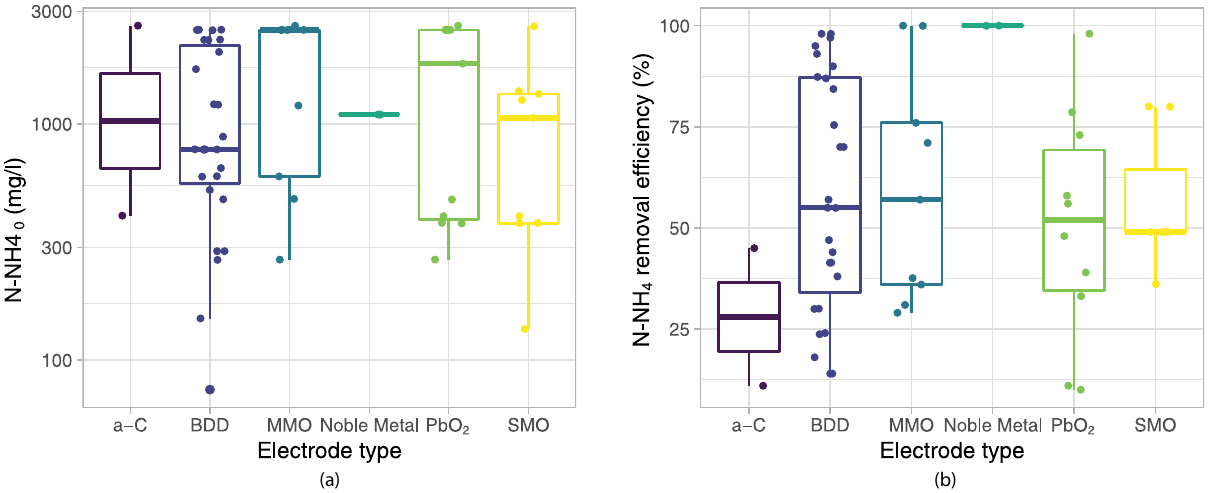
Fig. 3. Boxplots of (a) the initial N-NH 4 concentration and (b) the NH 4 removal ef fi ciency for every considered test, grouped by electrode type.